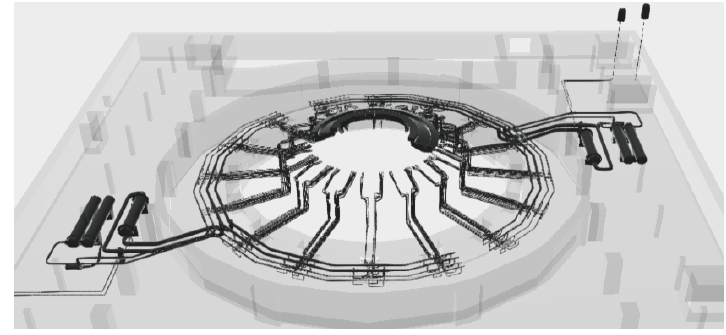
Figure 1. Representation of the EU-DEMO Divertor PHTS CAD